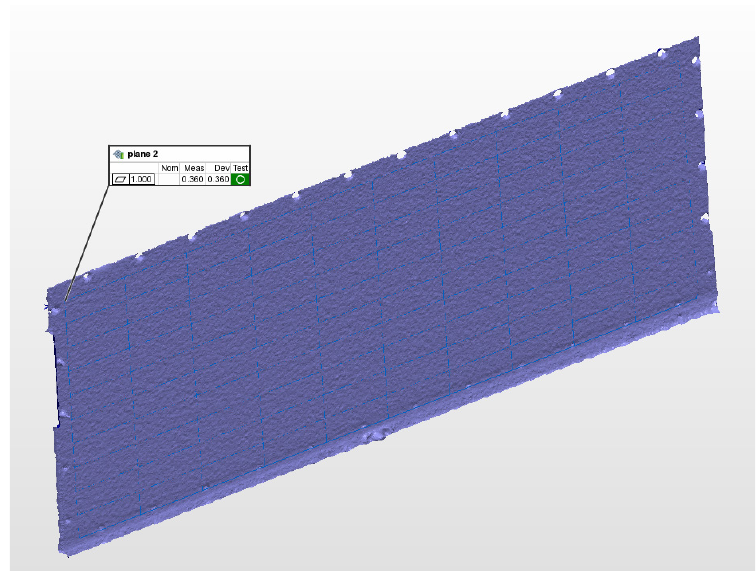
Figure 10. The re-construction of the metal plane based on the measured point cloud. As shown in Figure 11, the calculation method of the best fitting plane is used to calculate the point cloud of the white ceramic plane, which includes 1824 valid points. The purple plane is the plane formed by point cloud data, and the blue plane is the theoretical